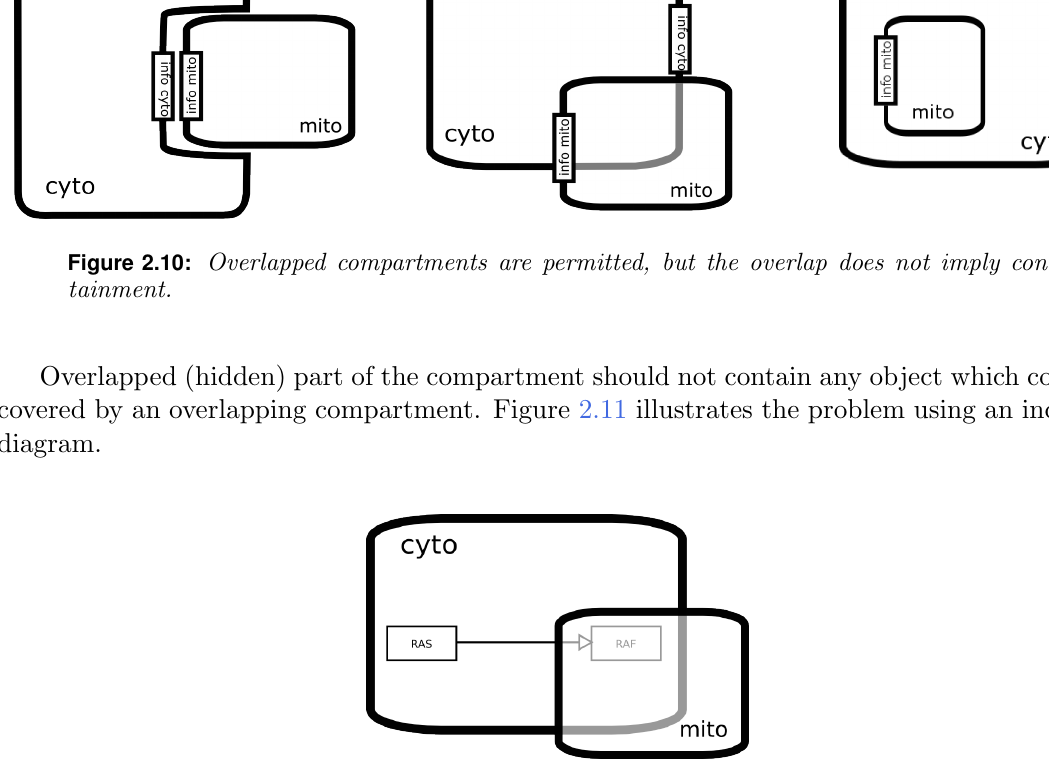
Figure 2.11: Example of an incorrect diagram. Overlapped compartments must not obscure other